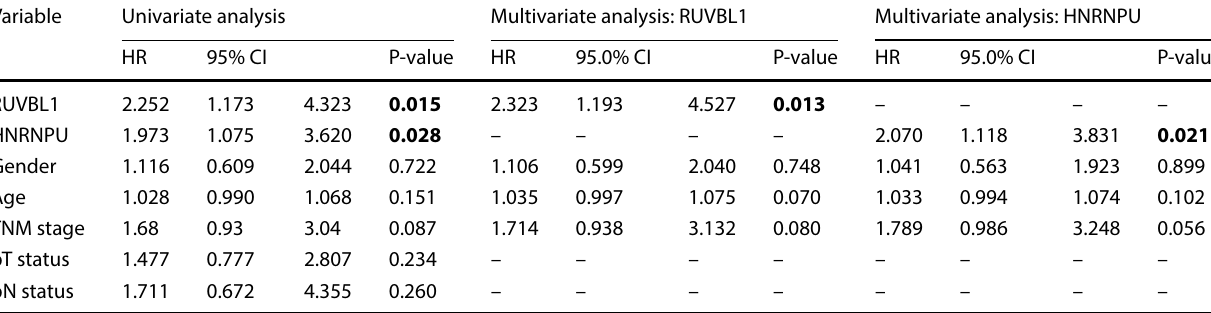
Table 3 Univariate and multivariate Cox proportional hazards models for OS of the NSCLC patients (n = 67)